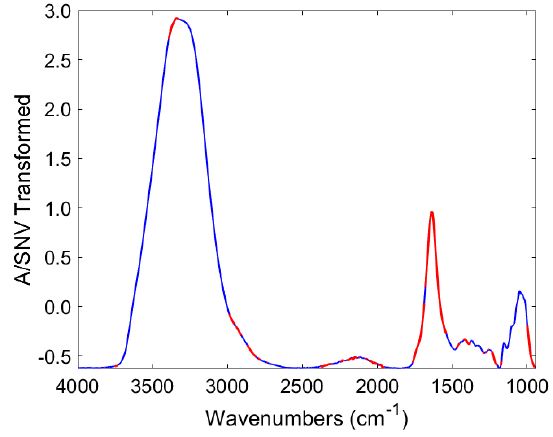
Figure 7. Importance of variables in PLS-DA: variables with VIP > 1 (red) and VIP < 1 (blue) .